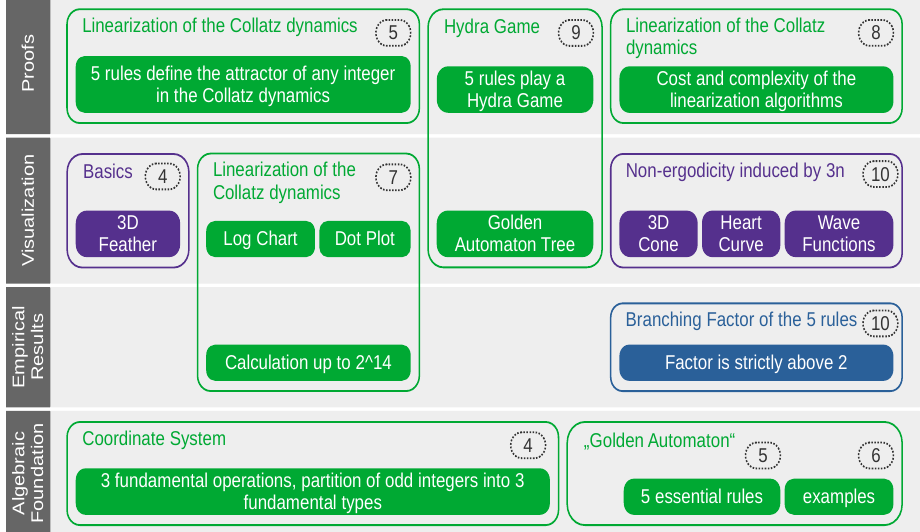
Figure 1. Structure of the original contributions of this